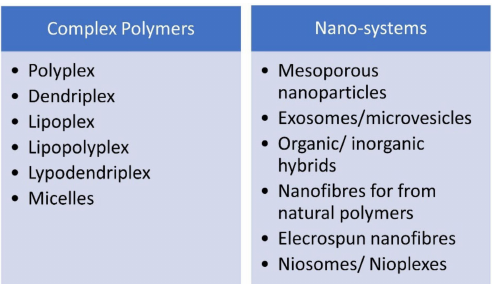
Figure 3. Examples of nVV systems for gene delivery in